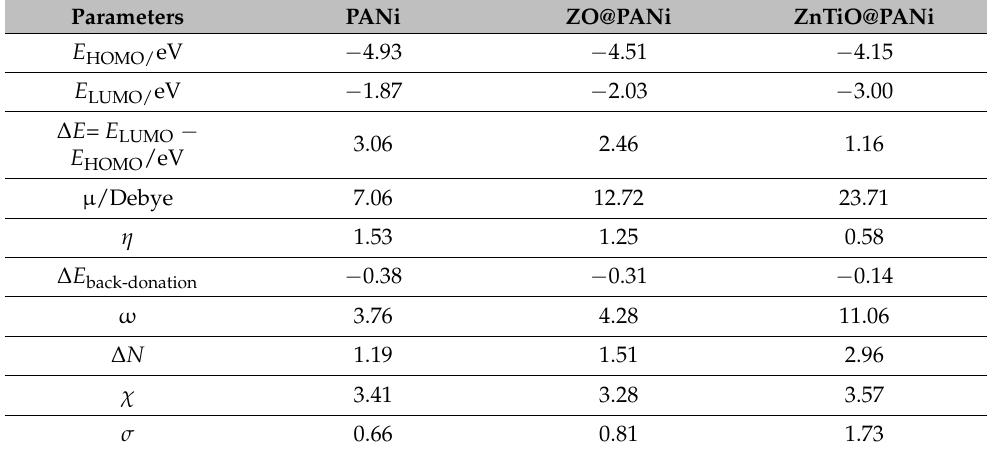
Table 4. DFT parameters of the studied